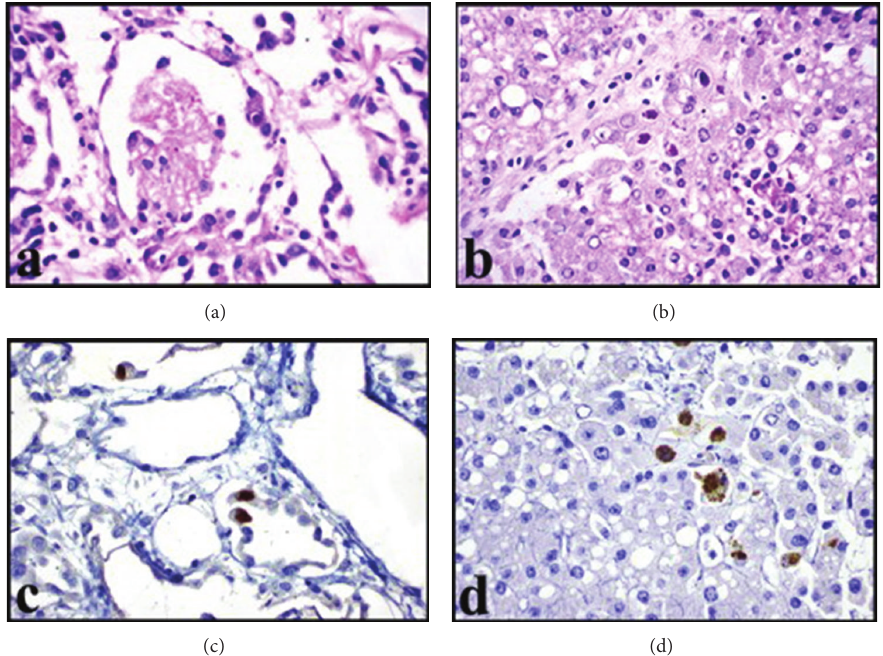
Figure 4: Postmortem biopsies of lung (a) and liver (b) include viral inclusion containing cells. Immunohistochemical CMV positivity in alveolar cells (c) and hepatocytes (d) (magnification (a, b, c, and d) ×